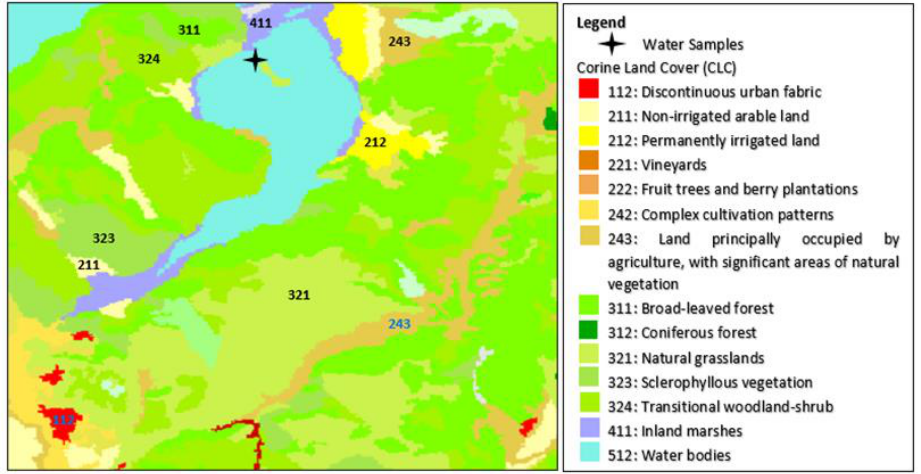
Figure 2. Map and sampling site (black mark) of Lake Mikri Prespa ( 40°47′23.2″ N 21°04′35.6″ E ).